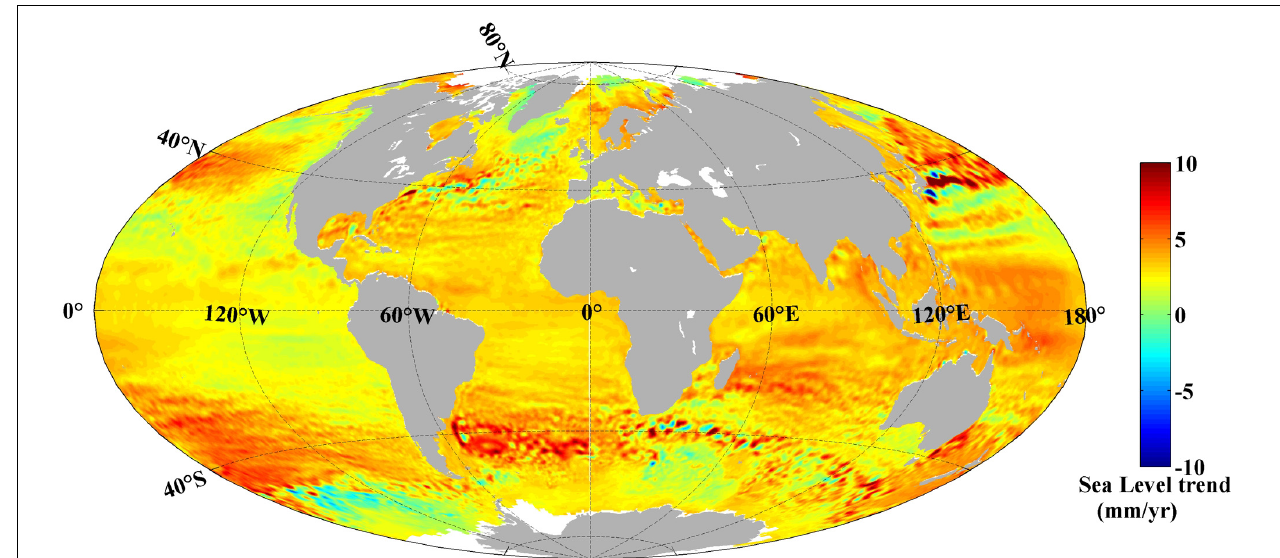
FIGURE 7 | Map of sea level trends (mm yr − 1 ) elaborated using 27 years of satellite multi-mission altimetry data (January 1993–October 2019). Credits EU Copernicus Marine Service